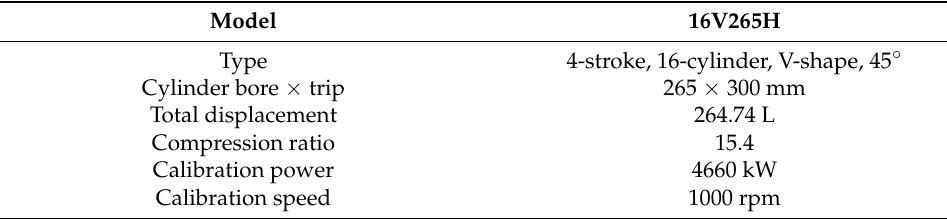
Figure 1. Simulation model of the entire diesel engine. Table 5. The main technical parameters of diesel